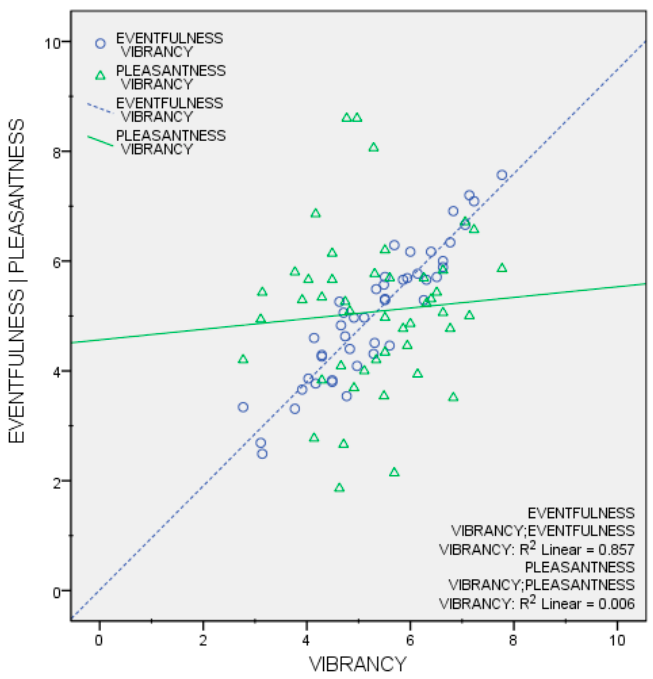
Figure 6. Scatterplots for mean vibrancy scores vs. mean eventfulness scores and mean vibrancy scores vs. mean pleasantness scores.